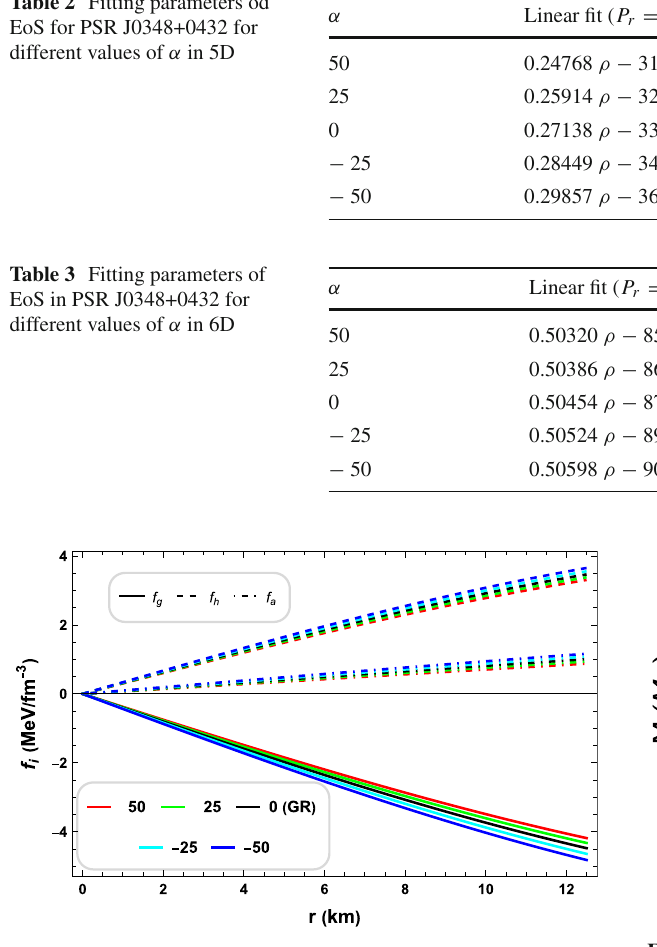
Fig. 17 ToV relation in PSR J0348+0432 for different α in 5D